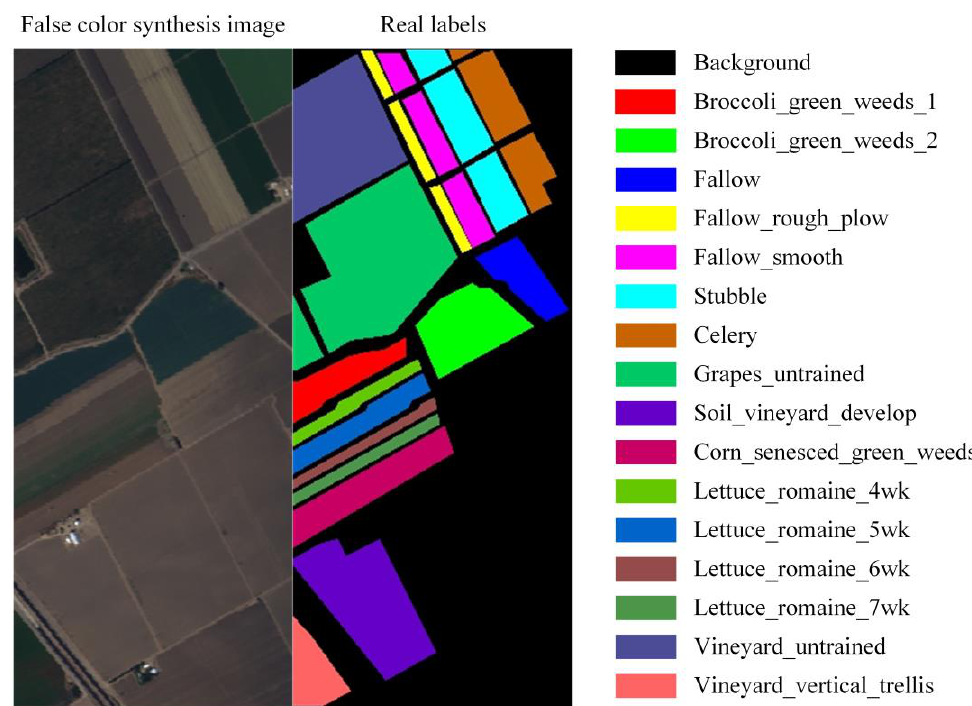
Figure 5. Salinas dataset. Table 1. Sample size of each class in each set after partitioning the Salinas dataset.